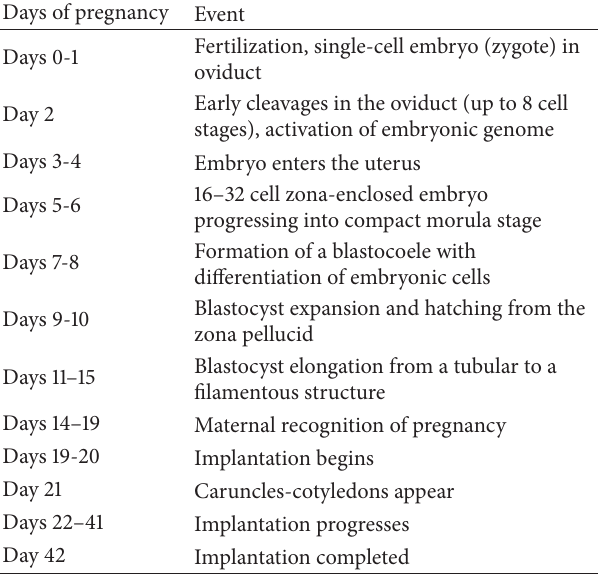
Table 1: Important events during the early embryonic